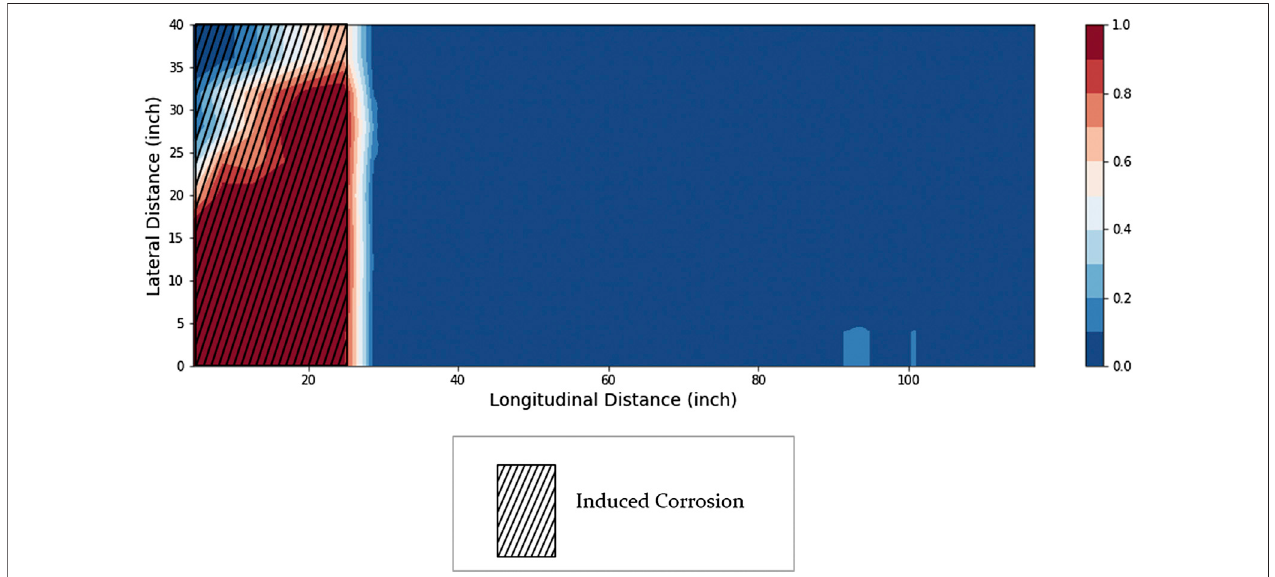
FIGURE 11 | Fusion heat map based on Support Vector Machine indicating existence of corrosion in slab.